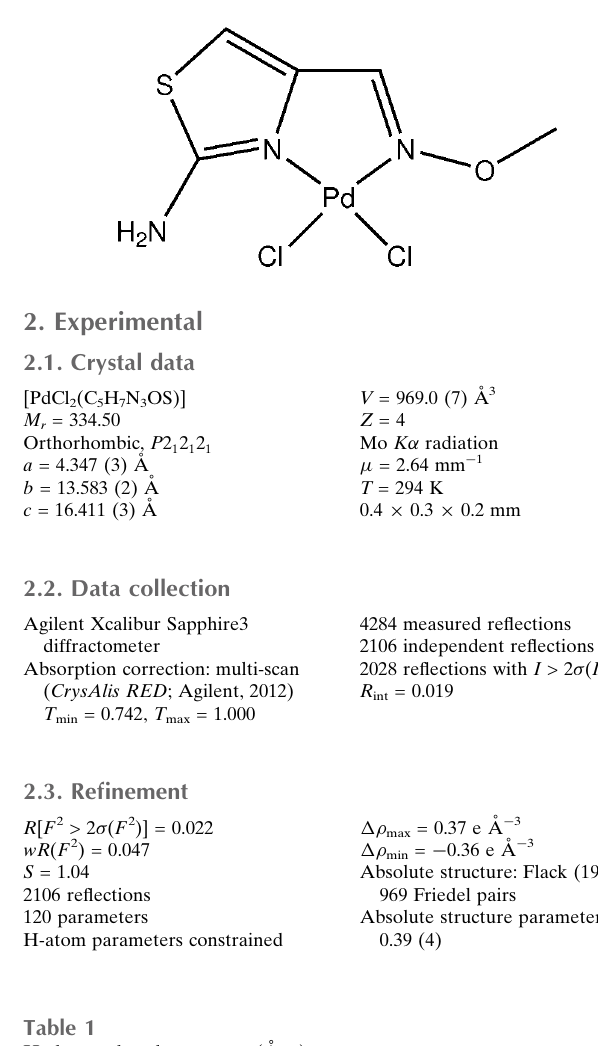
Hydrogen-bond geometry (A˚ , (cid:2)